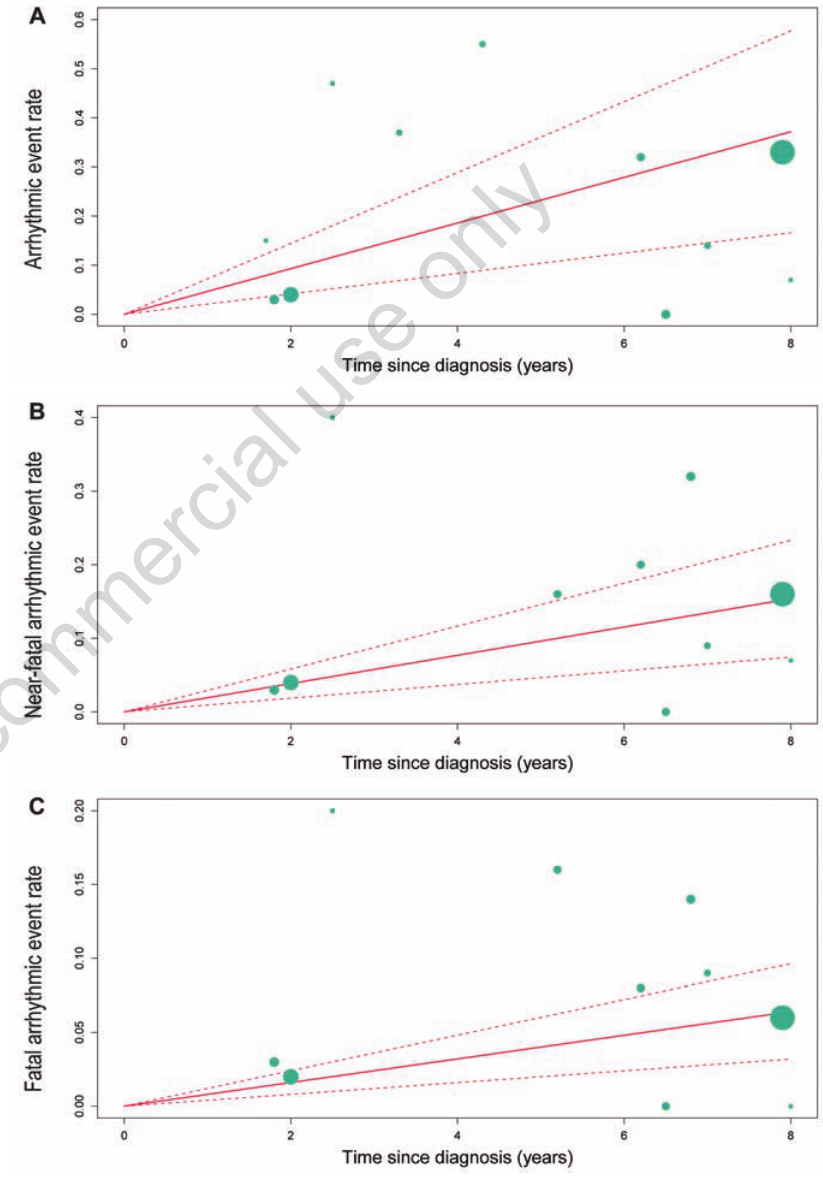
Figure 4. All (A), near-fatal (B) and fatal (C) arrhythmic event curves in catecholaminer- gic polymorphic ventricular tachycardia (CPVT) patients on β -blockers therapy. The red line and its corresponding area indicate the proportion of patients with arrhythmic events and its corresponding 95% confidence interval based on a random-effects meta-analysis model. The green data points represent the arrhythmic event rates of the individual stud- ies. The area of each data point is proportional to its number of patients and statistical weight. Adapted from van der Werf et al., 41 with